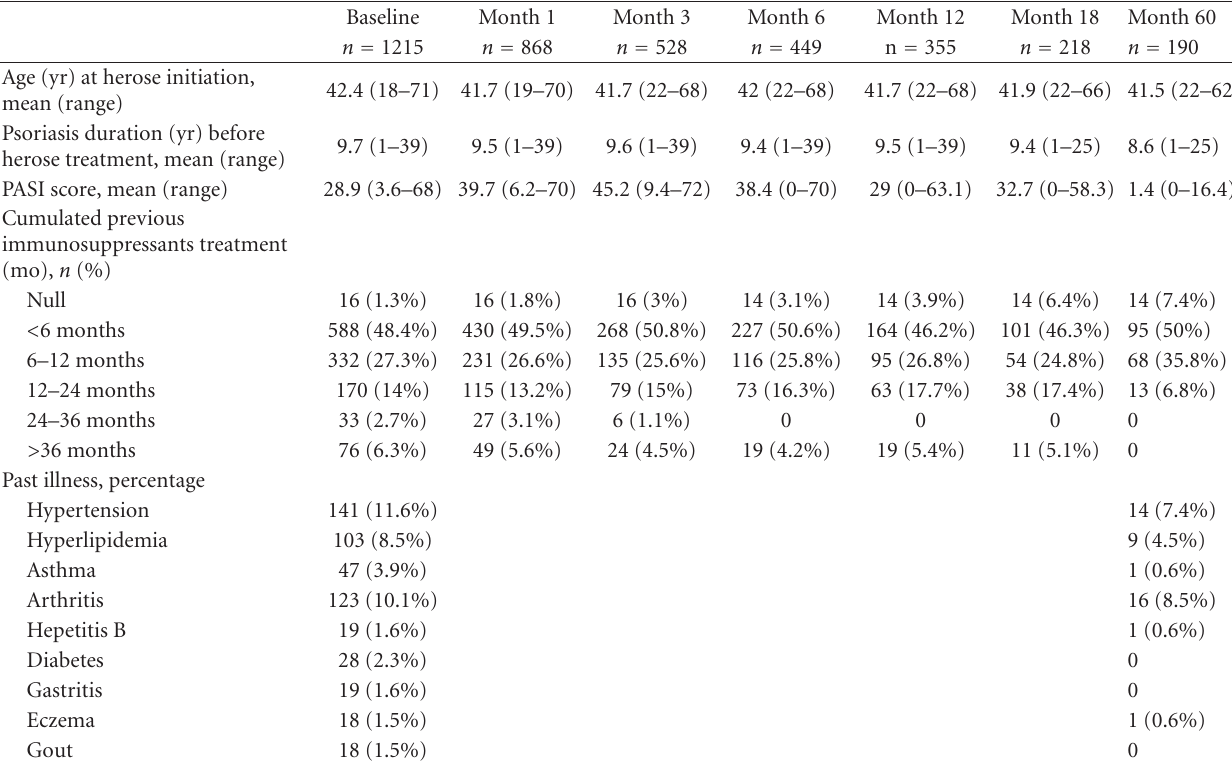
Table 2: Baseline characteristics and follow-up data of the 1215 psoriasis patients with herose treatment.